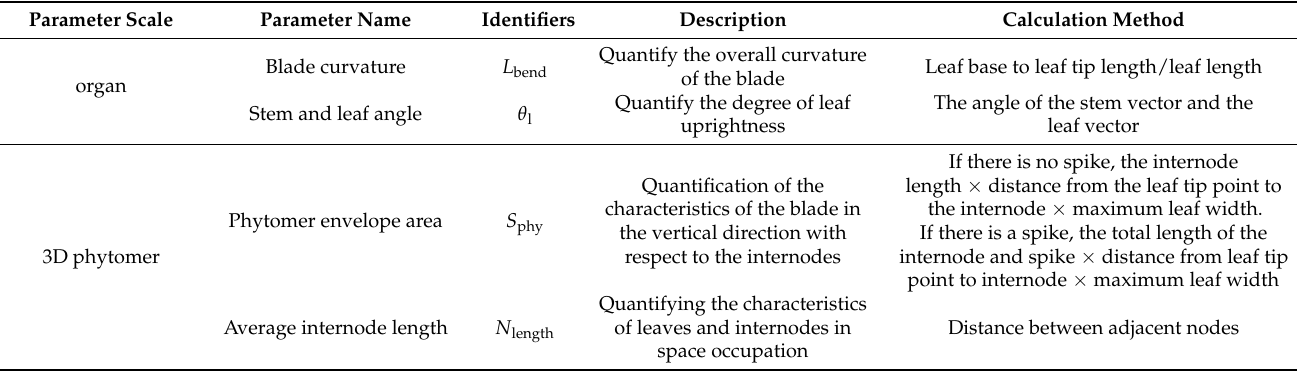
Table 3. Multi-scale phenotypic parameters used in plant architecture